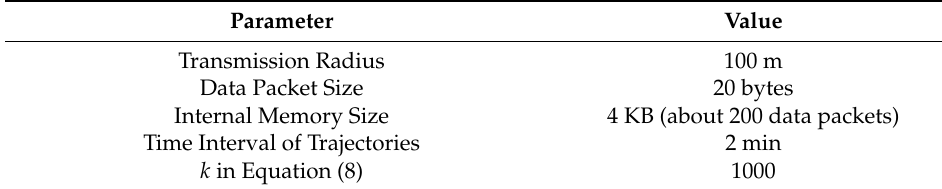
Table 1. Key parameters on the experiment.